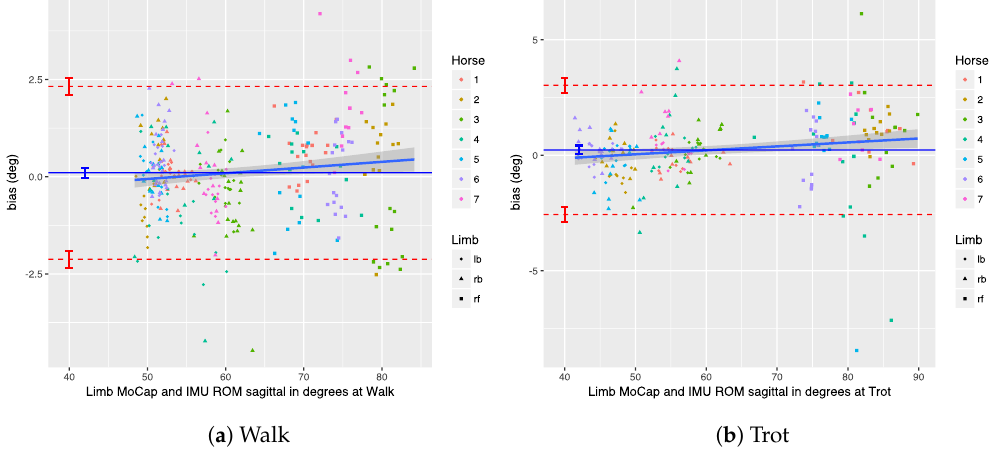
Figure 23. Bland–Altman analysis for sagittal range of motion (ROM) at walk and trot.